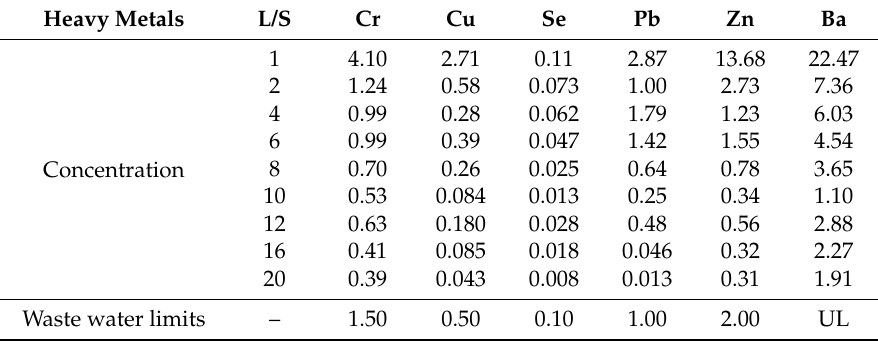
Table 3. The evolution of the concentration of heavy metals vs. L/S.